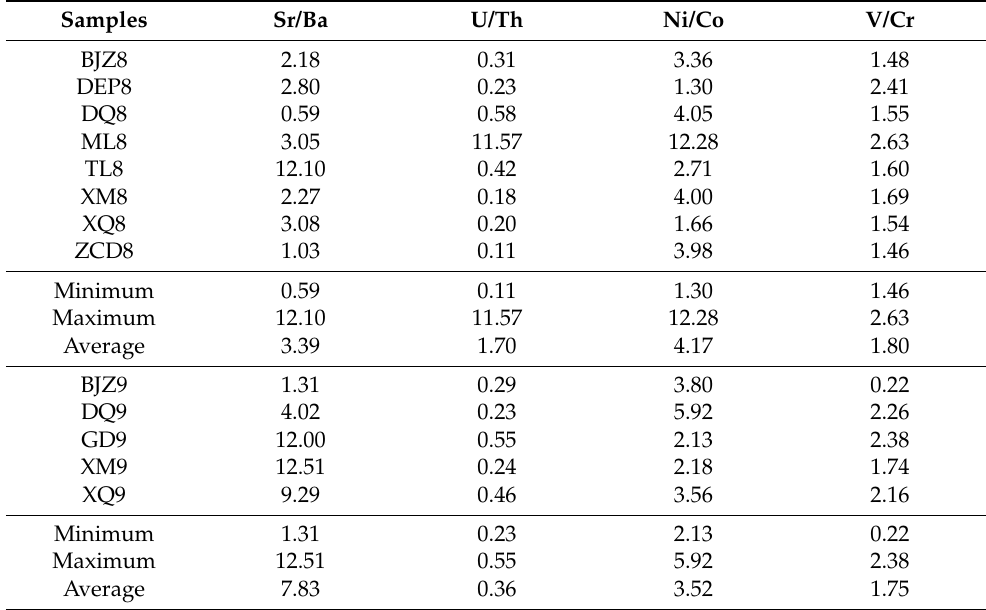
Table 9. Element content